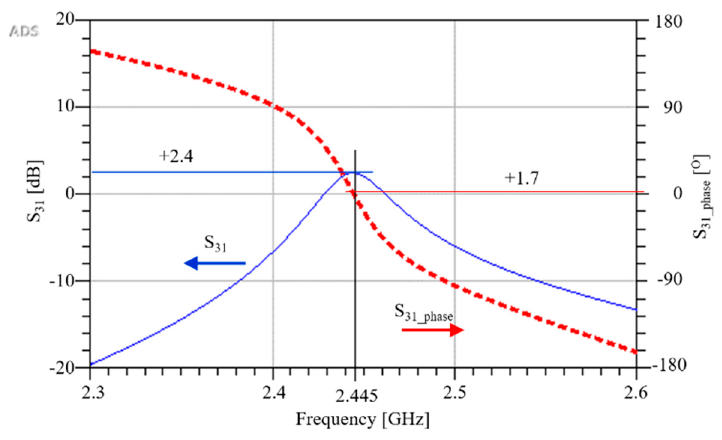
Figure 6. Simulated S 31 and S 21 of the power oscillator.